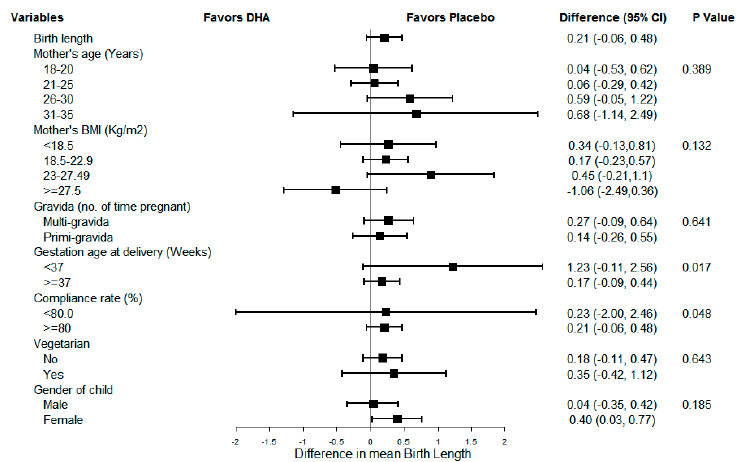
Figure 3. Sub-group analysis for newborn birth length.